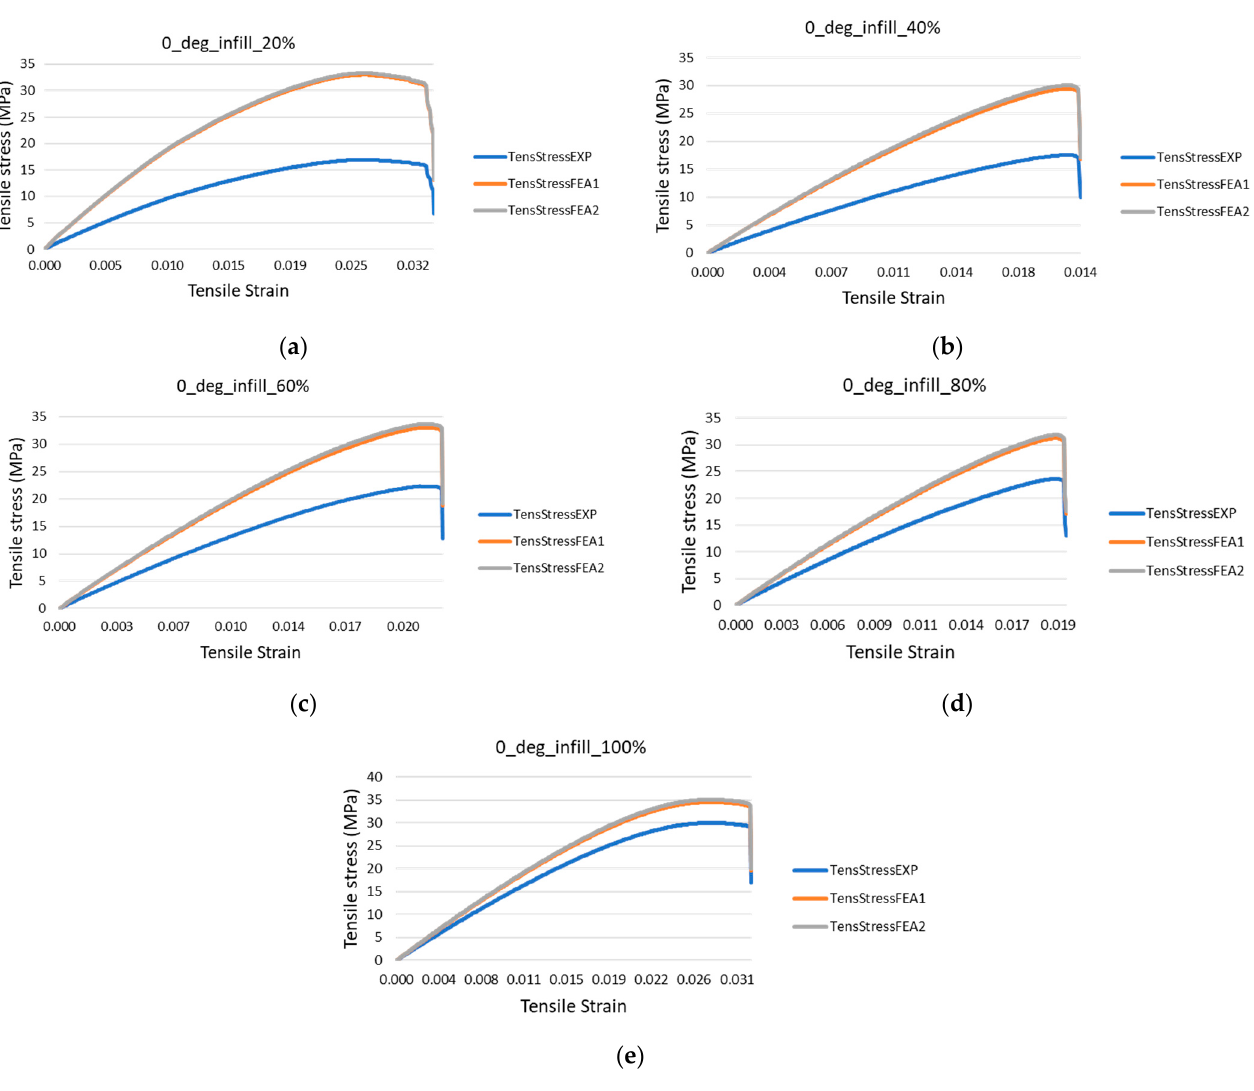
Table 4. Tensile modulus of the printed specimens with geometrically determined cross-section. Infill